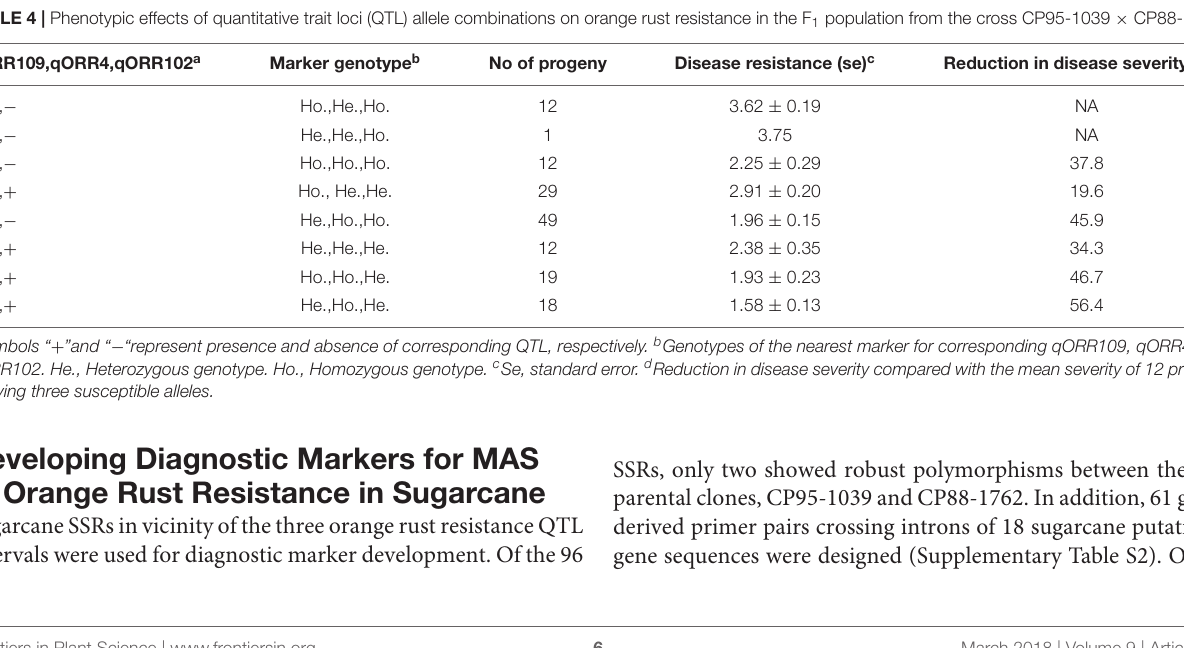
TABLE 3 | Quantitative trait loci (QTL) associated with orange rust resistance of the F 1 population derived from the cross CP95-1039 × CP88-1762. Trait QTL LGs a Position (cM) LOD Additive effect PVE (%) b Marker c Distance (cM) d Orange rust qORR109 P1LG109 27.3 19.3 − 2.07 58 2SNP350 2 Orange rust qORR4 P2LG4 29.5 5.4 0.9 12 5SNPUN3354 0.2 3SNP3092 2.2